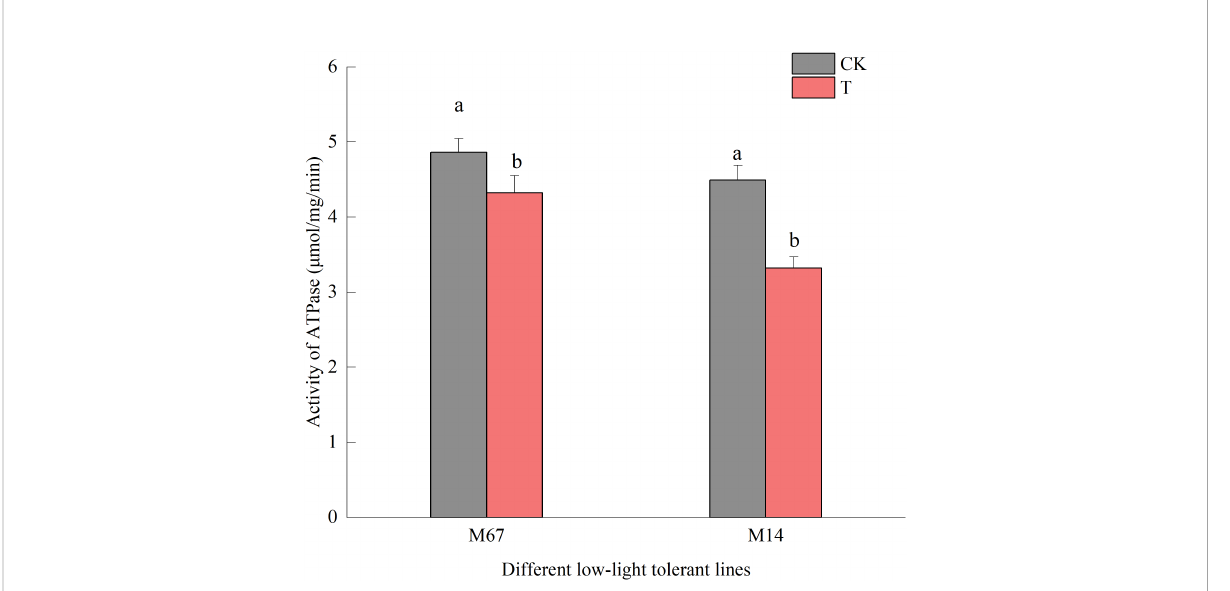
FIGURE 4 Effects on activity of ATPase of low light in different cucumber lines. Lowercase letters a and b after the value represent statistically signi fi cant differences (p < 0.05) within a variety under different low-light treatments as determined by the least signi fi cant difference test.